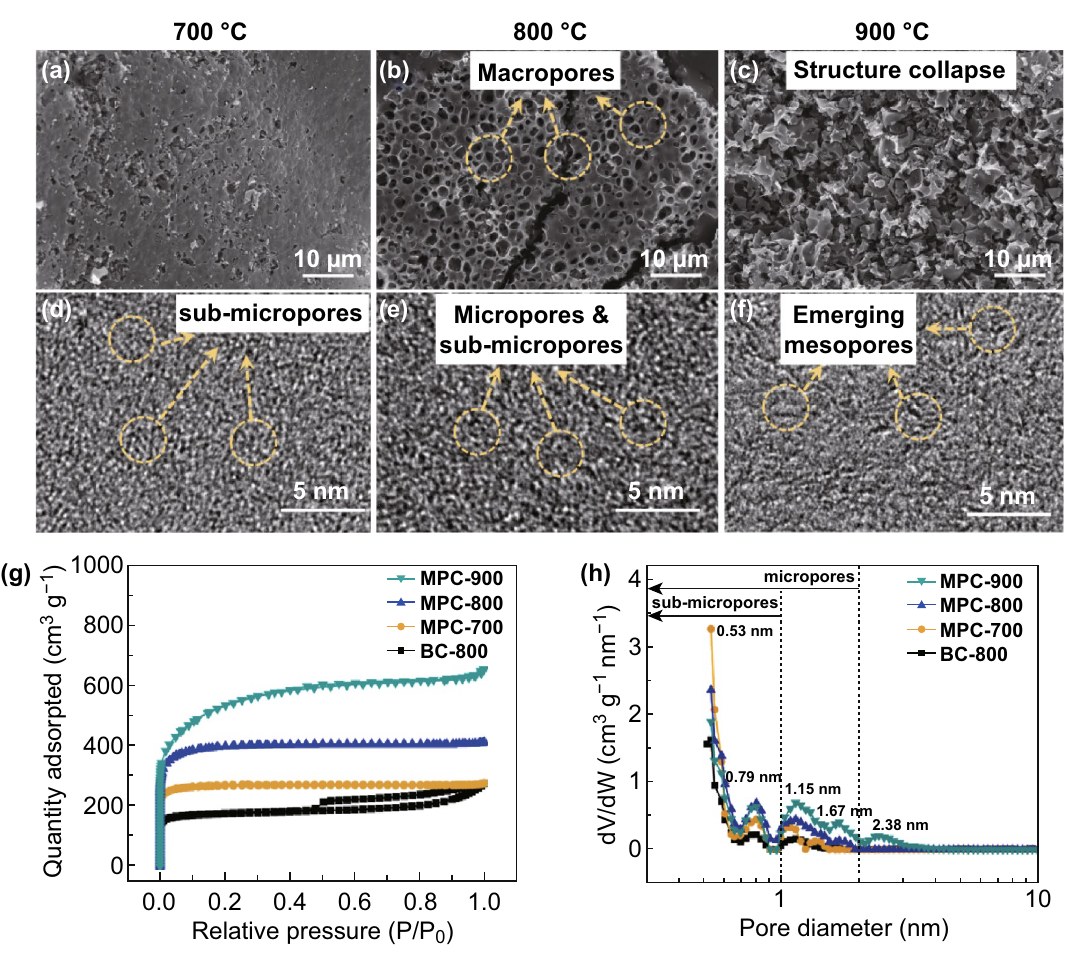
Fig. 2 Morphologies and pore structure of the MPCs treated under various temperatures. SEM images of a MPC‑700, b MPC‑800, and c MPC‑ 900. HR‑TEM images of d MPC‑700, e MPC‑800, and f MPC‑900. g Nitrogen adsorption–desorption isotherms. h Pore size distribution of BC‑800 and MPCs